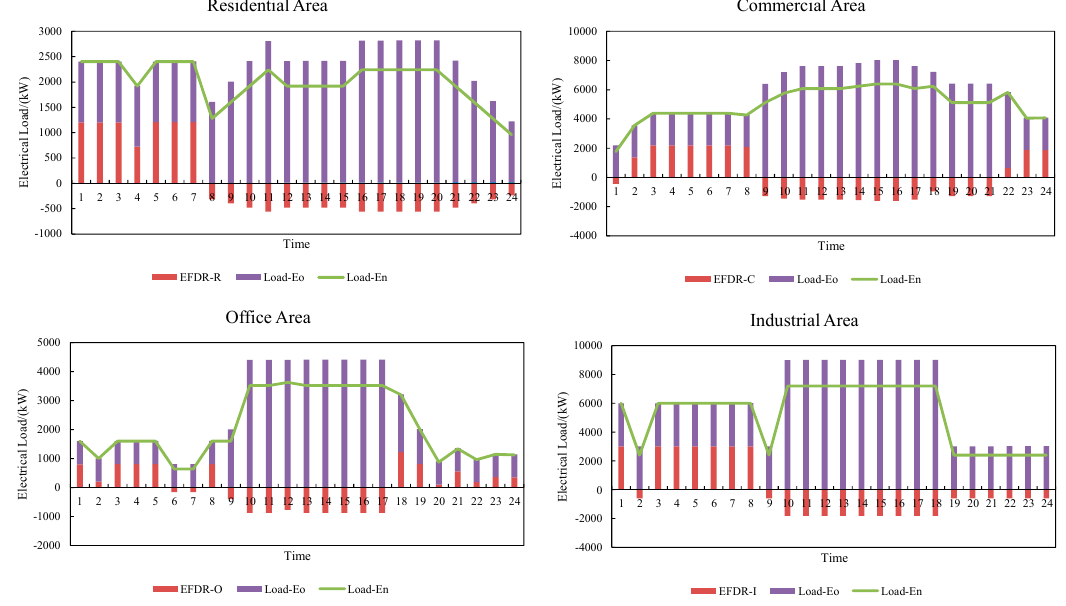
Figure 6. Shift situation of electrical load after FDR of electric load.